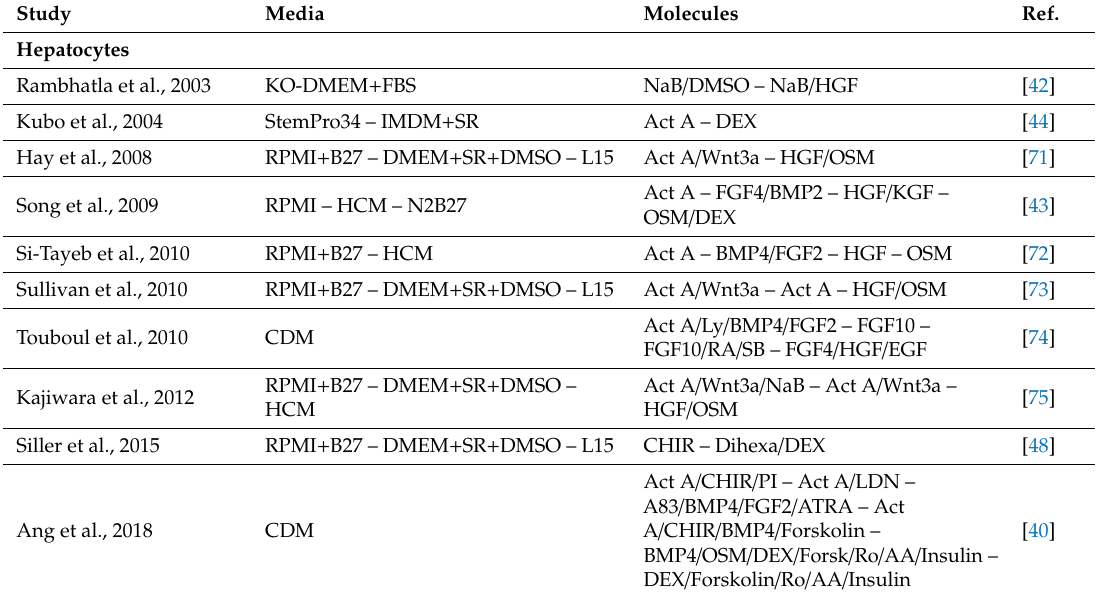
Table 1. Methods for di ff erentiation of human pluripotent stem cells into hepatic